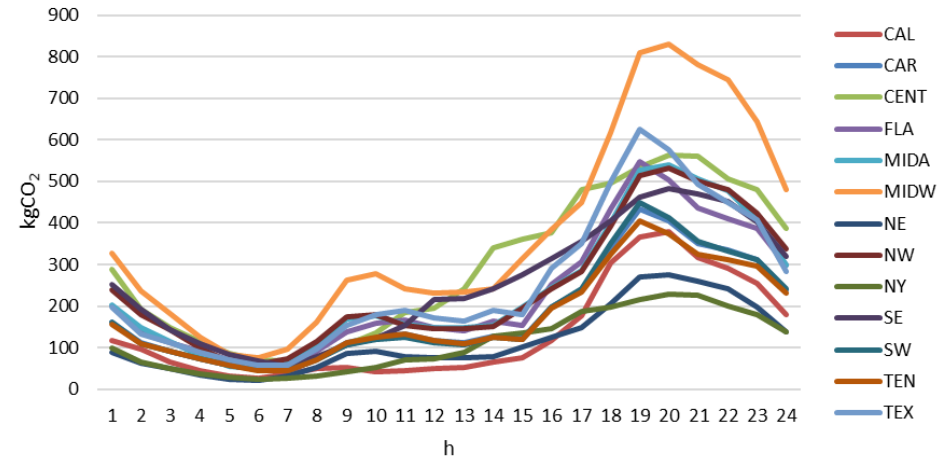
Figure 7. GHG emissions with the charging of one EV in each